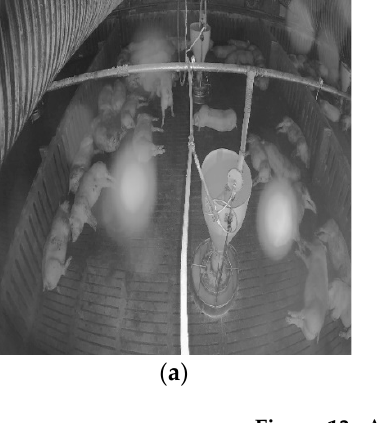
Figure 13. Attention map calculated by the attention module on real-noise images: ( a ) real-noise image; ( b ) heatmap of the corresponding attention map of each layer in the model.